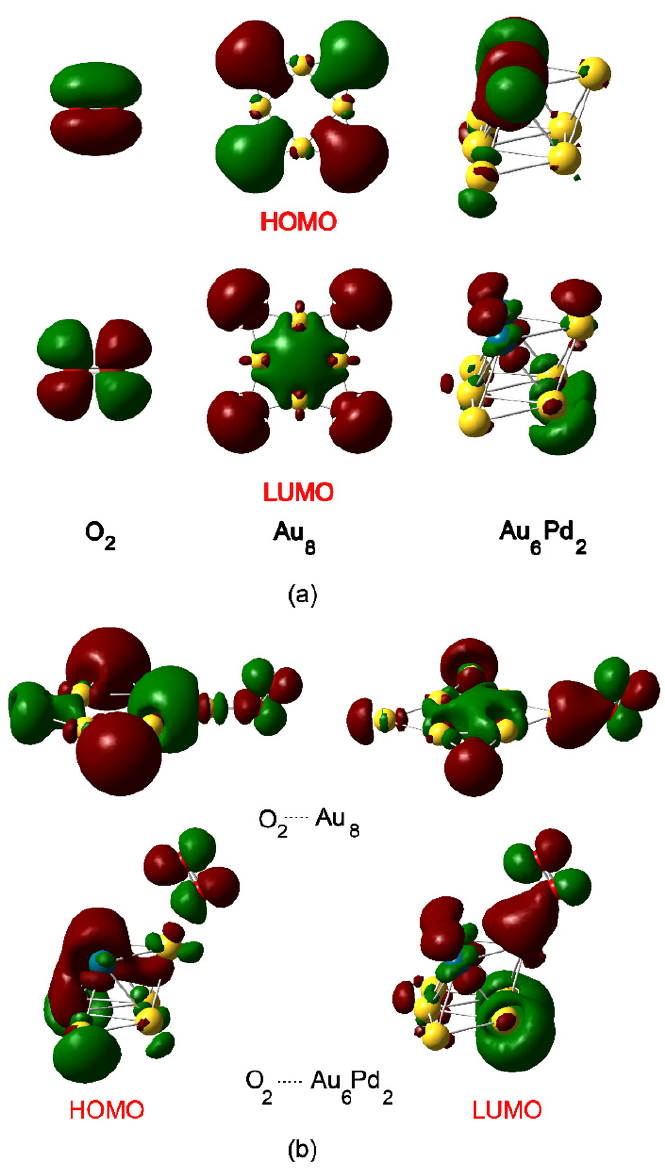
Figure 2 . ( a ) HOMO and LUMO of O 2 , Au 8 and Au 6 Pd 2 ( b ) Frontier orbitals of the adsorption complex of Au 8 and Au 6 Pd 2 with O 2 (the contour value is 0.02 electron/Å 3 ).